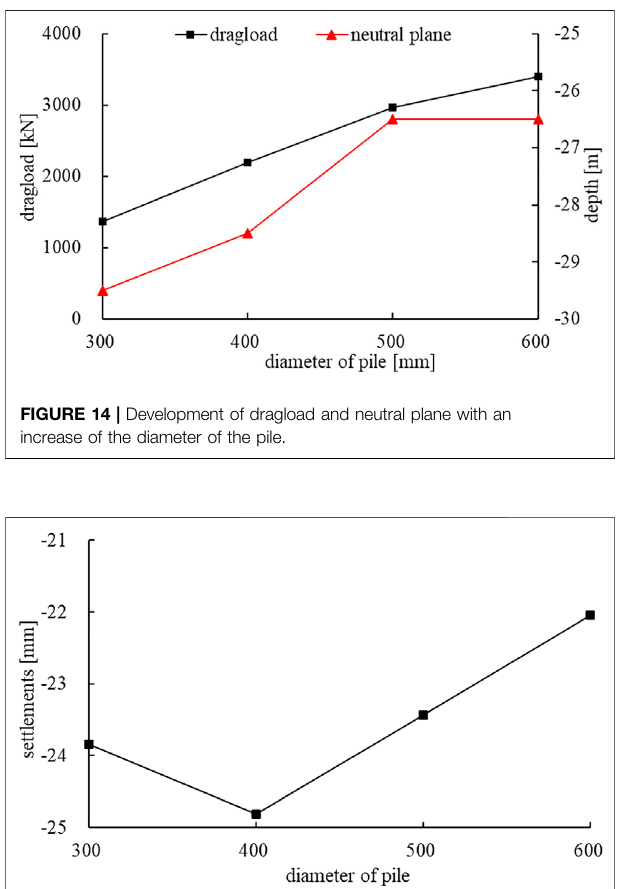
FIGURE 15 | Development of the settlements with an increase of the diameter of the pile.